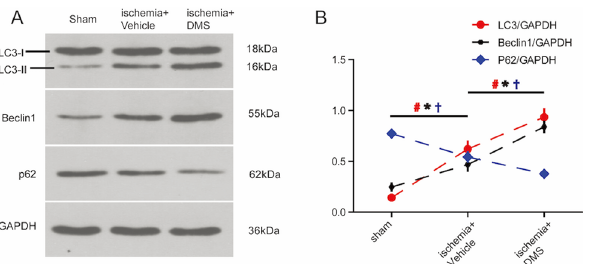
Fig 6. The S1P signaling pathway regulates activation of autophagy, post stroke. A, Impact of SphK inhibitor,DMS, on expressionof Beclin1, LC3, and the main autophagysubstrate, p62, detected by western blotting. Results are representative of 4 independentexperiments. B, Quantificationof the results from panel A (n = 4 for each group, # p < 0.05 vs. sham group, ** p < 0.01 vs. ischemia+vehicle group, one-wayANOVA with Tukey post hoc